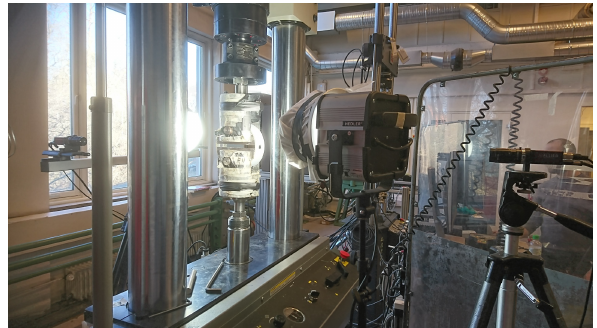
Figure 3: Split disk setup with composite ring installed. Cameras on each side and strong lights to provide enough light for the short shutter